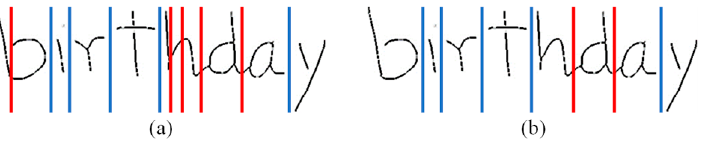
Figure 9. Over-segments removal: ( a ) Image with fixed and projection segment lines, and ( b ) image with correct segment lines.